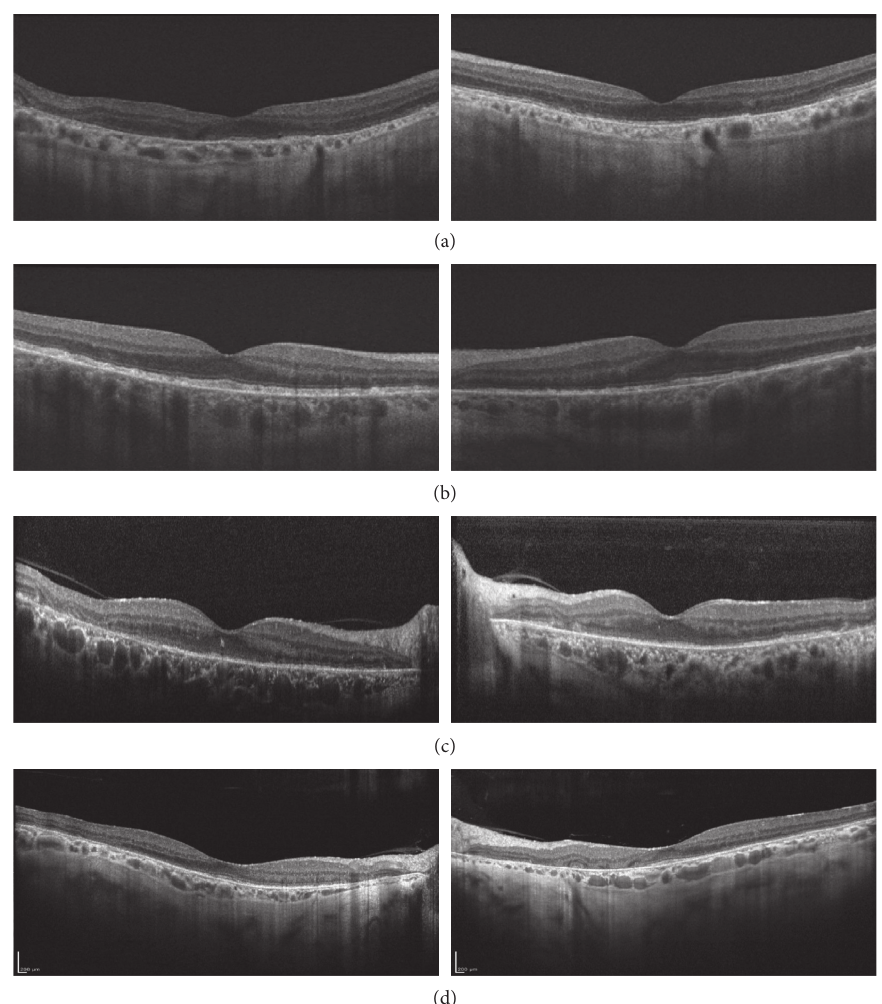
Figure 4: Spectral domain optical coherence tomography of the foveal center in patient 1 (a), patient 2 (b), patient 3 (c), and patient 4 (d) demonstrates attenuation of outer retinal lamination and retinal thinning. There is a diffuse loss of outer retinal reflectivity at the level of the RPE, ellipsoid zone (aka IS/OS junction), and an external limiting membrane. There are areas of increased choroidal transmission co- incident with areas of RPE loss and disorganization of retinal